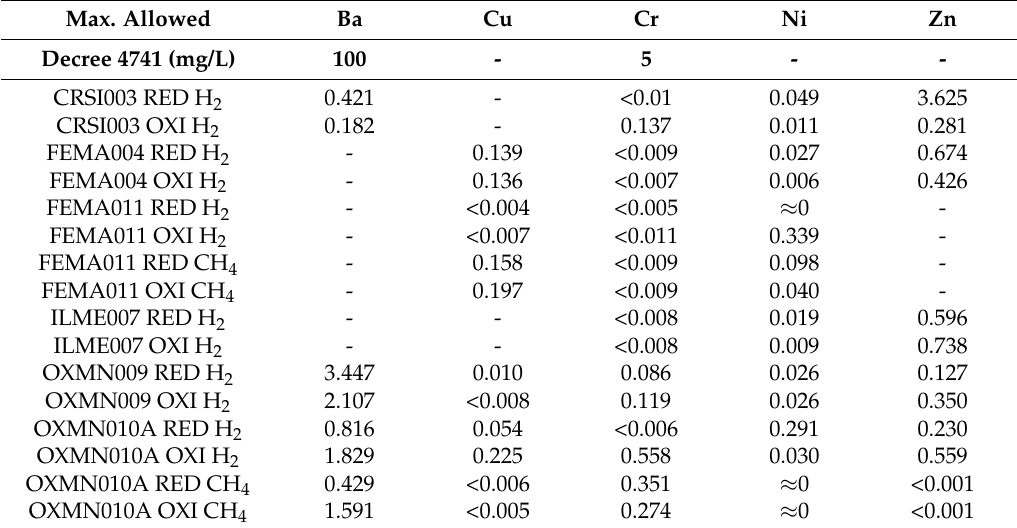
Table 6. Concentration of metals in the leachate of OC residues and maximum values allowed by Colombian regulations (Decree 4741. 1-27, 2005). Max.